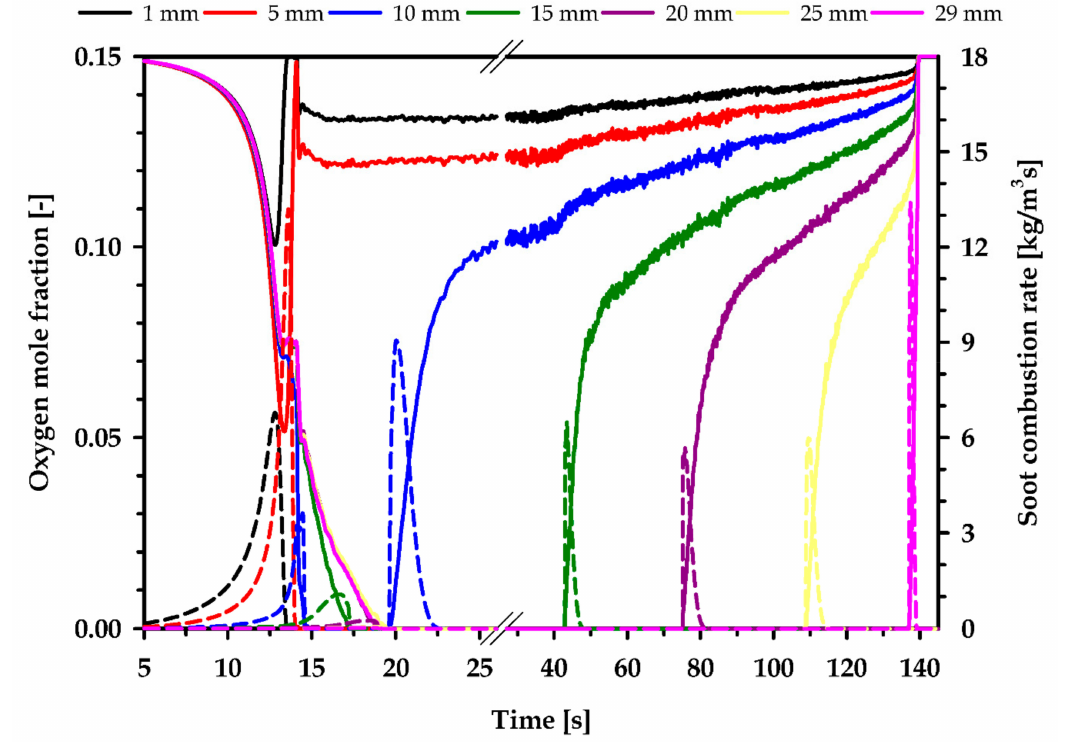
Figure 8. Time histories of oxygen mole fraction (solid lines) and soot combustion rate (dashed lines) (monitor points of Figure 2): k = 200 (V in = 1 m /